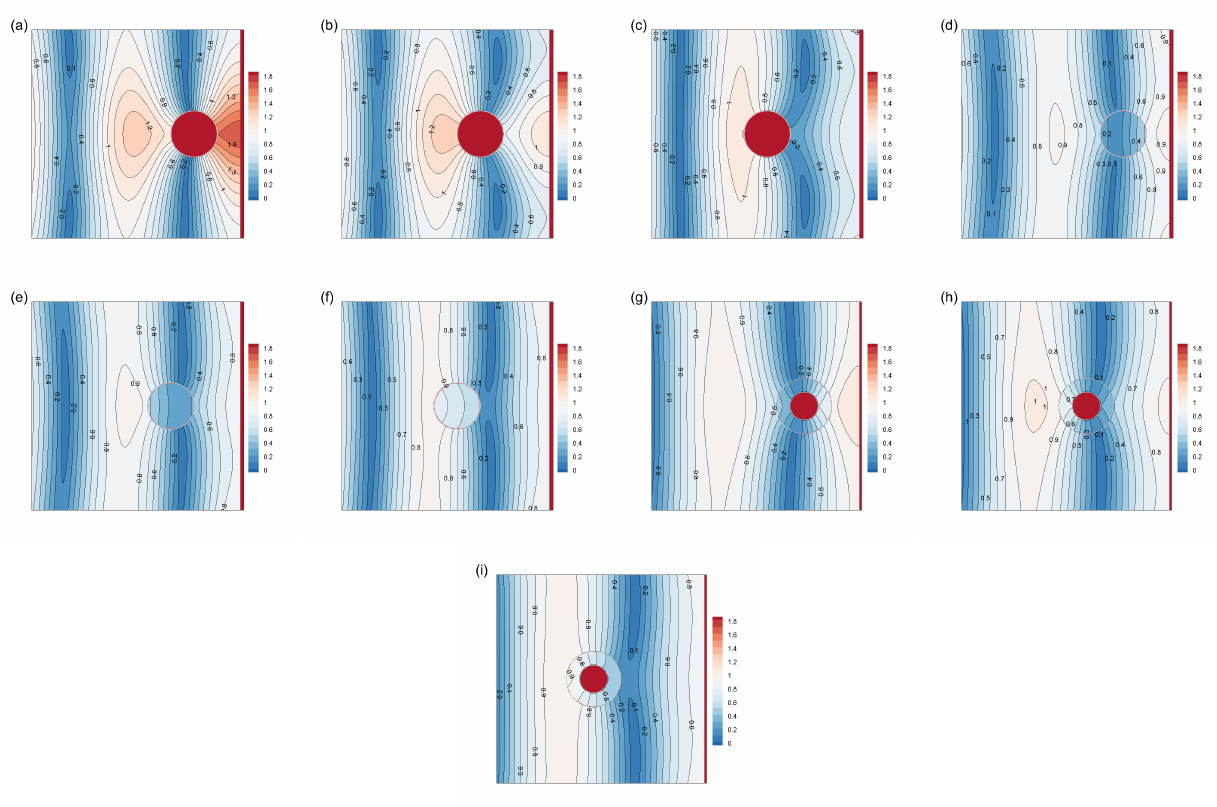
Figure 16. Dimensionless wave elevation in the vicinity of the three different configurations with h / a = 1.5, b / a = 0.5, and C w = 1.5: ( a ) a = b , e / a = 1; ( b ) a = b , e / a = 2; ( c ) a = b , e / a = 3; ( d ) b = c = 0, e / a = 1; ( e ) b = c = 0, e / a = 2; ( f ) b = c = 0, e / a = 3; ( g ) e / a = 1; ( h ) e / a = 2; ( i ) e / a =